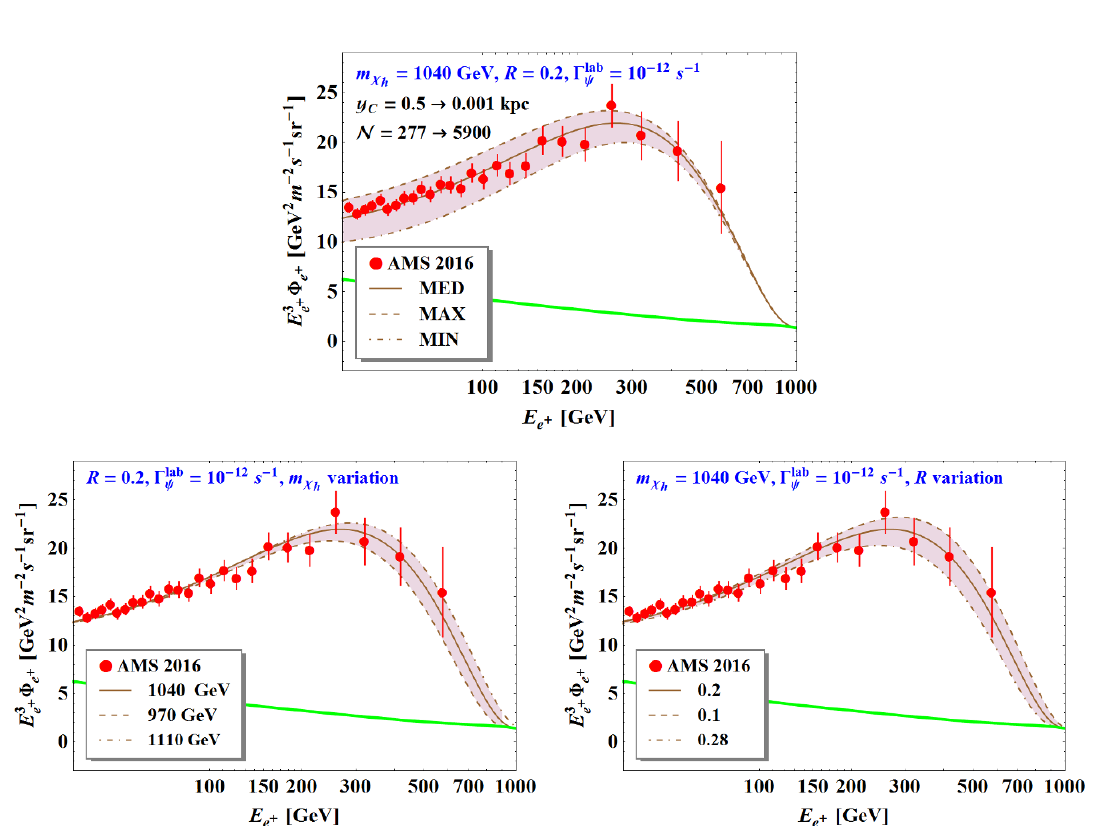
Figure 3 . The (cid:12)t results of the scenario in (cid:12)gure 1 into the positron spectrum reported by the AMS-02 Collaboration [1]. The (cid:12)ts are performed with 26 data points within 35{600 GeV. Upper panel: the best-(cid:12)t with the variations of y C , N , and the galactic cylinder model. The variation in y C and N is performed under the MED model, while the best (cid:12)t is retained, i.e., the choice of ( y C ; N ) = (0 : 5 kpc ; 277) yields the same minimum (cid:31) 2 value as the choice of ( y C ; N ) = (0 : 001 kpc ; 5900) does. Lower-left and lower-right panels: the (cid:12)t sensitivities to m (cid:31) (lower-left) and R (lower-right) with h the other (cid:12)t parameters set to be their respective best values. R stands for the ratio of the lighter DM mass to the unstable state mass, i.e., R (cid:17) m (cid:31) =m . For both cases, we choose y C = 0 : 5 kpc, l N = 277, and the MED